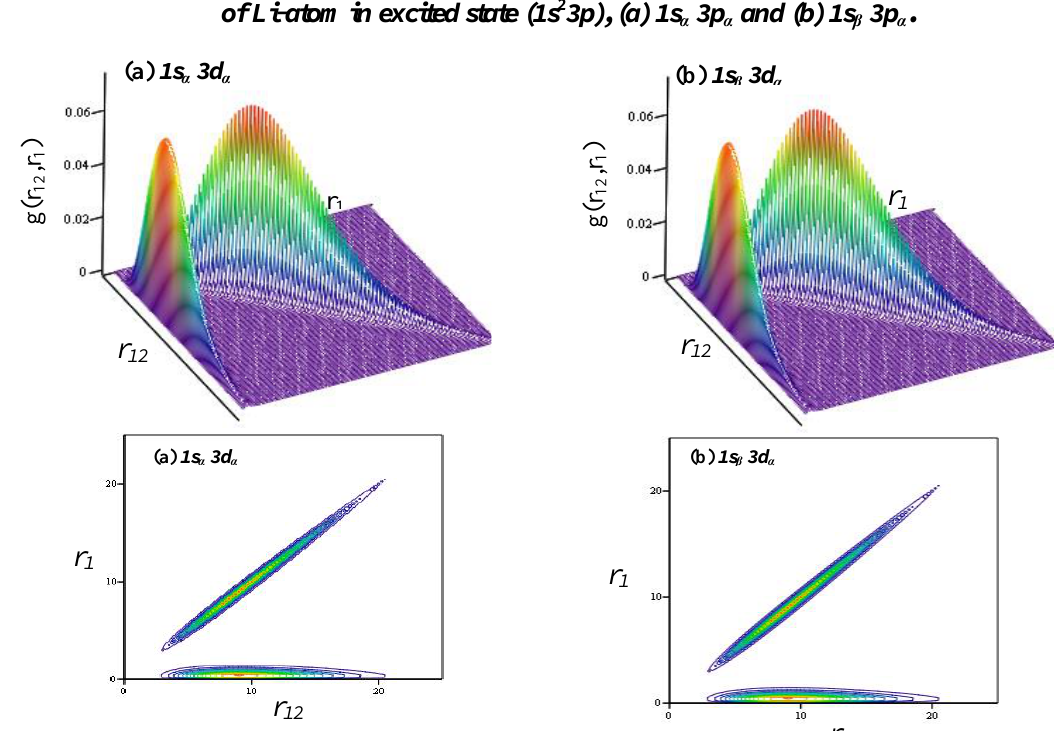
 , rrg for 1s 3p state 212